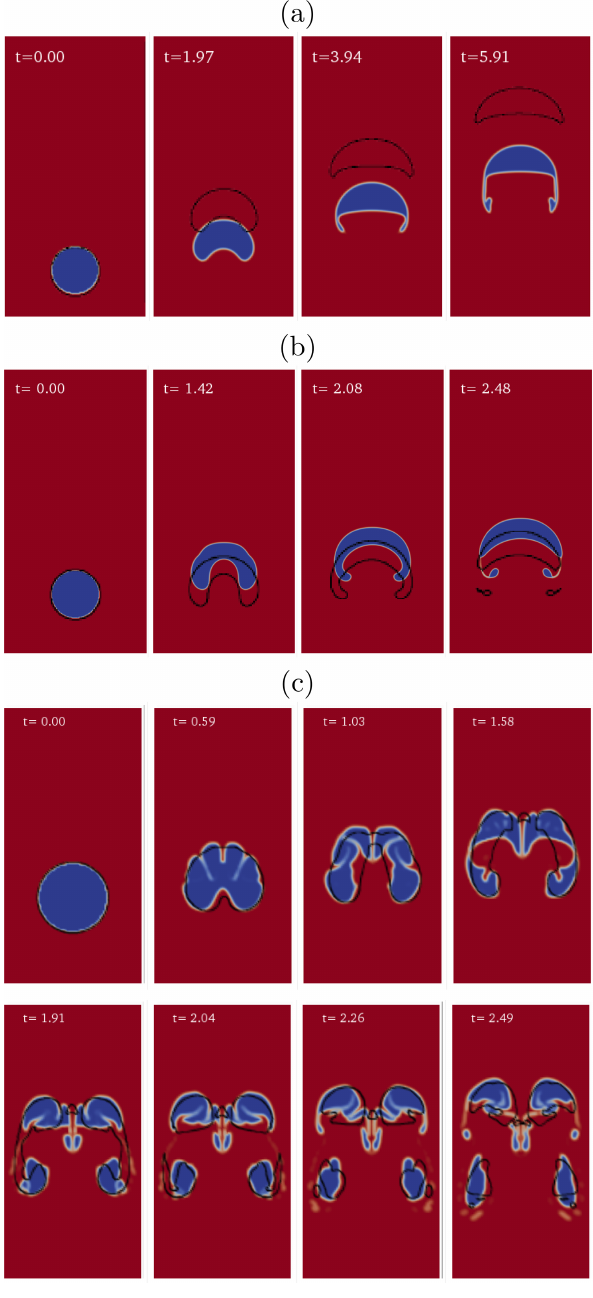
Figure 7. Simulations of bubble rise in a basaltic melt using interFoam are compared with the results of Suckale et al. (2010a) (black lines) for three different regimes: (a) no breakup ( Re ≈ 5, Fr 2 ≈ 0 . 4, We ≈ 90, and (cid:53) = 10 − 6 ), (b) gradual breakup ( Re ≈ 25, Fr 2 ≈ 0 . 3, We ≈ 800, and (cid:53) = 10 − 6 ), and (c) catas- trophic breakup ( Re ≈ 250, Fr 2 ≈ 0 . 16, We ≈ 1350, and (cid:53) = 10 − 6 ). For each regime, snapshots at different nondimensional times are shown. To be consistent with Suckale et al. (2010a) here 02 we use the square of the Froude number ( Fr 2 = v ga